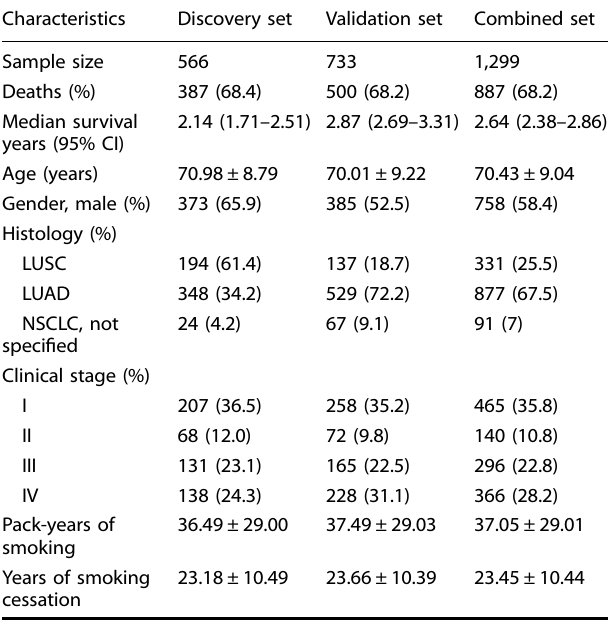
Table 1. Demographic and clinical characteristics of long-term former smoking NSCLC